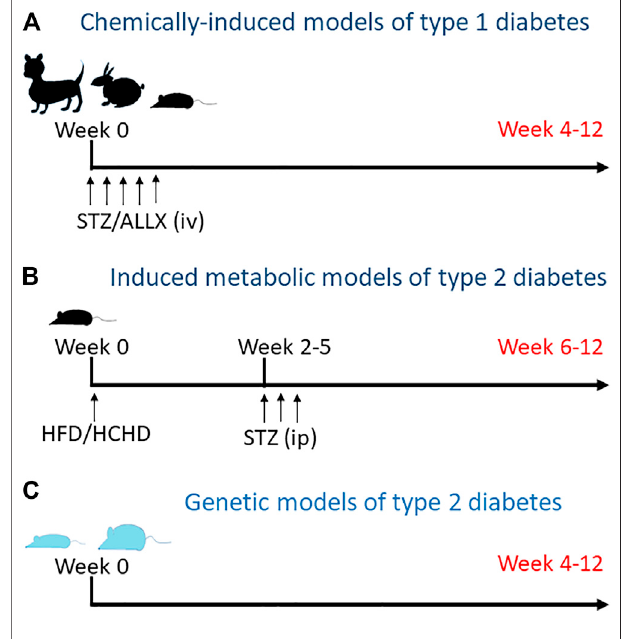
FIGURE 1 | Animal models for diabetes. (A) Type 1 diabetes is induced by intravenous injection of streptozotocin or alloxane to kill pancreatic beta cells. Depending on the species, one or more consecutive injections of the toxic arerequired. (B) Metabolic models fortype 2diabetesinclude diet- induced insulin resistance followed by mild to medium pancreatic toxicity. Animals are fed with high fat and/or high carbohidrate diet (HFD and HCHD, respectively) for some weeks to generate insulin resistance and then receive one or more intraperitoneal injections of low dose streptozotocin to reduce beta cell mass. (C) Genetically hyperinsulinemic and/or hyperglycemic animals, lean and obese, spontaneously develop diabetes over